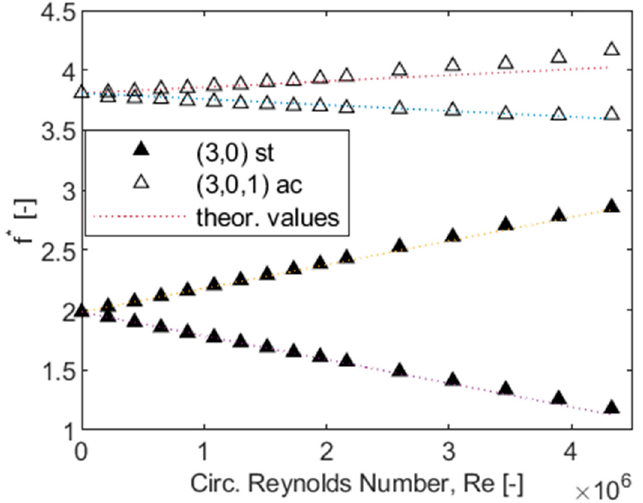
Figure 10. Normalized natural frequencies of three nodal diameter mode pair in air at 0.1MPa for “slim cavity” over circumferential Reynolds number. Experimental and theoretical results (a core rotation factor of 0.25 is adopted for the theoretic values of the acoustic wave).